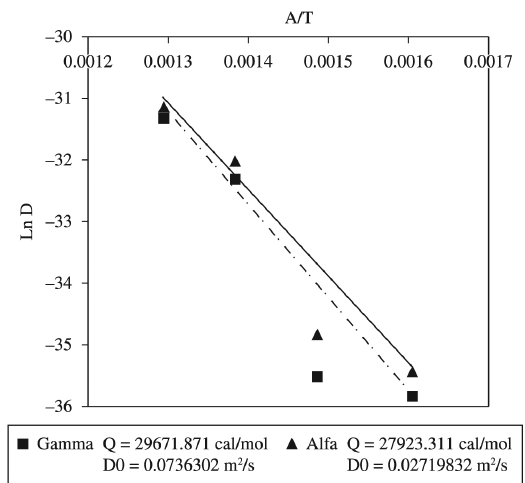
Figure 5. Determination of the activation energy and de preexponencial constant using a linear regression.